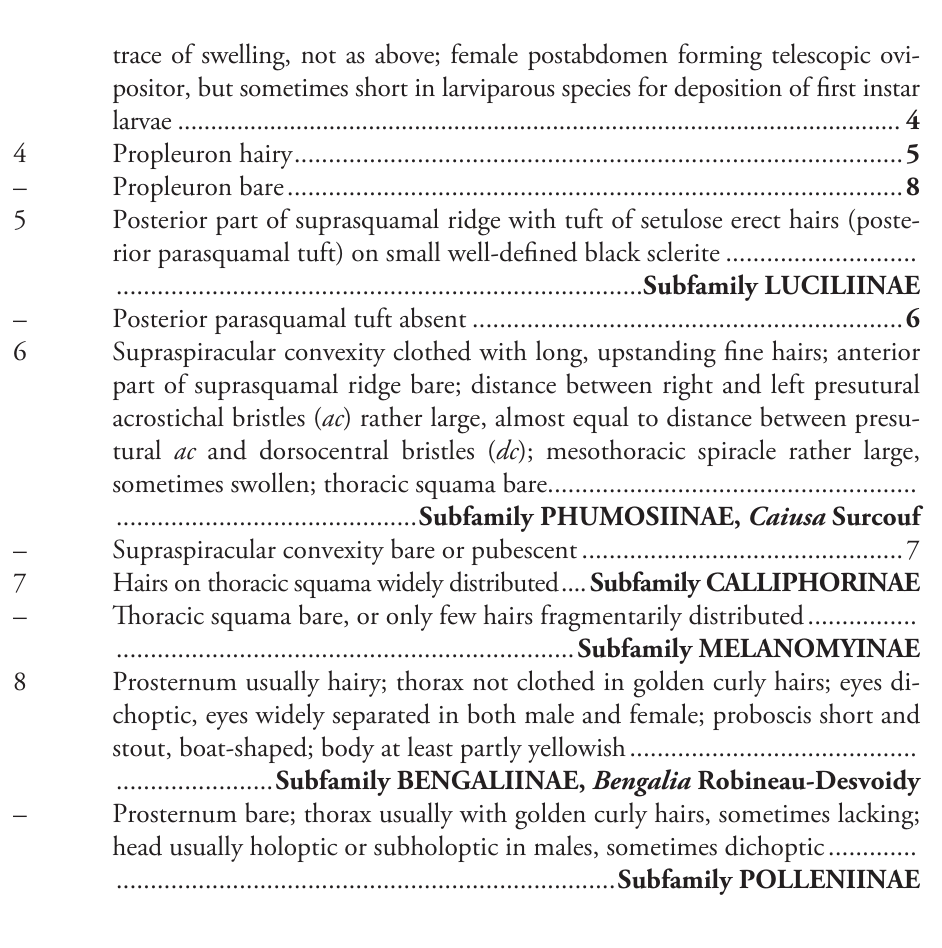
Head almost always with a very large facial carina; propleuron and proster- num almost always hairy; hind tibia with apical posteroventral bristle ( pv ); outer posthumeral bristle ( ph ) situated mesad of presutural bristle ( prs );